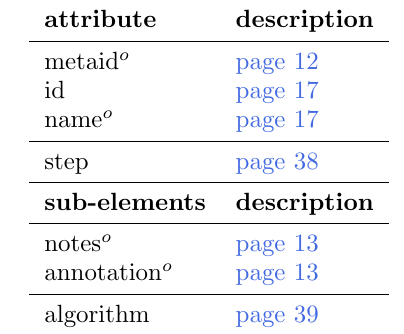
Table 2.15: Attributes and nested elements for oneStep. o denotes optional elements and attributes.